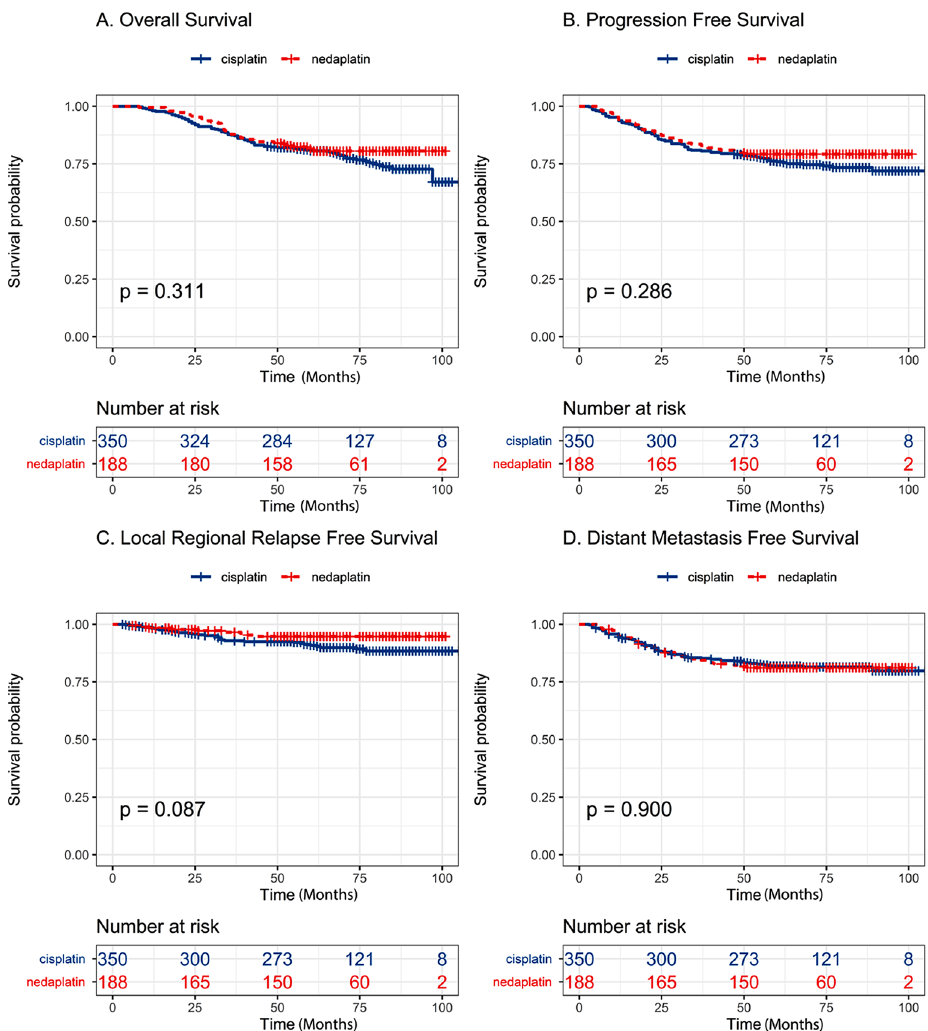
Figure 1. Kaplan ‒ Meier survival curves for radiotherapy with cisplatin-based chemotherapy or nedaplatin- based chemotherapy in the 538 patients with stage II ‒ IVa nasopharyngeal carcinoma. ( A ) Overall survival. ( B ) Progression-free survival. ( C ) Locoregional relapse-free survival. ( D ) Distant metastasis-free survival. P values were calculated using the log-rank